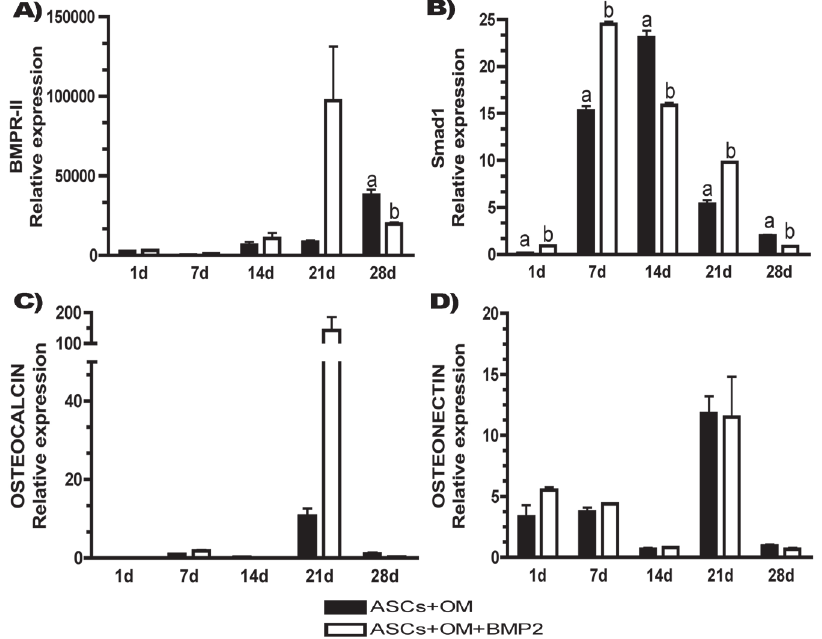
21. Figure 3 did not show differences between ASCs+OM and ASCs+OM+BMP2 groups at day 28, while MC3T3-e1 demonstrated a weak expression. ASCs+OM+BMP2 expressed the lowest BMP-7 levels at day 7. The expressions were similar for all groups at day 14. At day 21, ASCs+OM+BMP2 showed the highest expression of this protein.